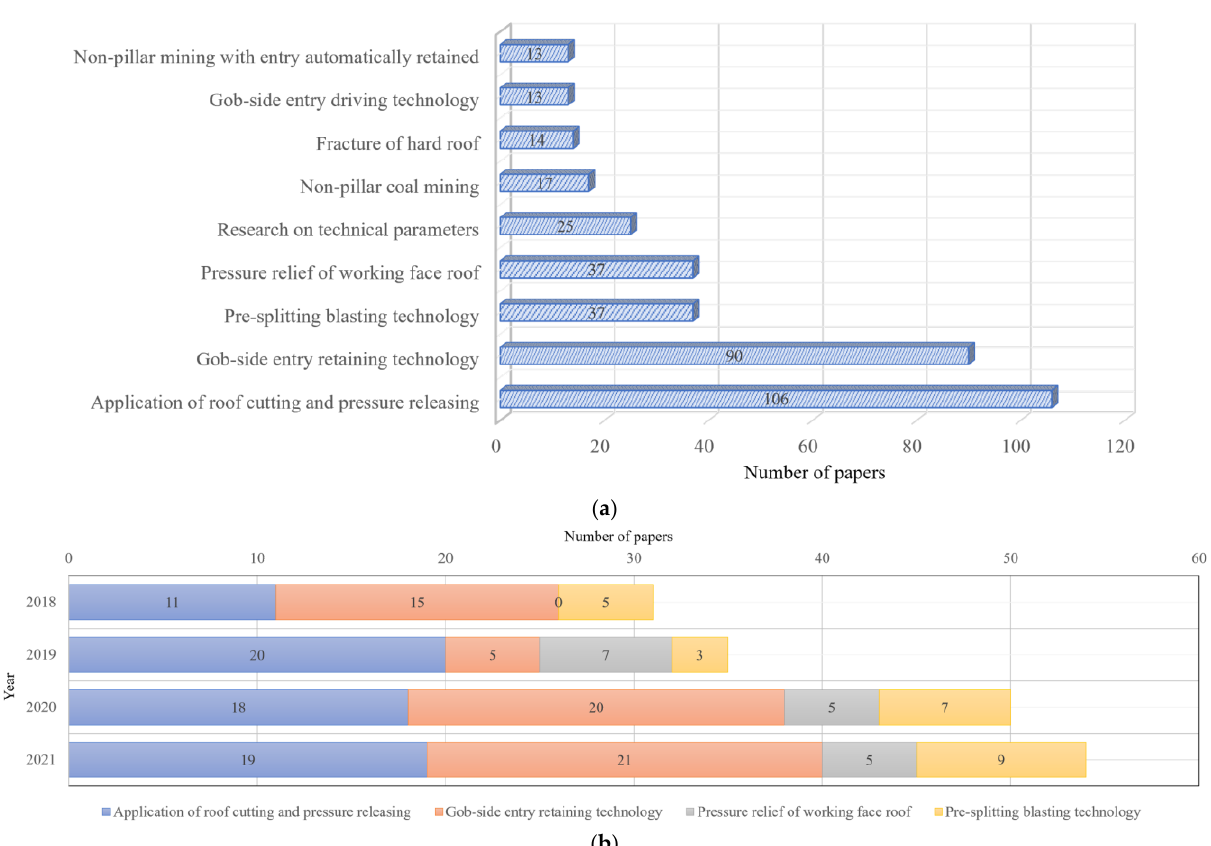
Figure 3. Category of pre-splitting and roof-cutting technology. ( a ) Nine research hotspots ( b ) Research trends in the past four years.